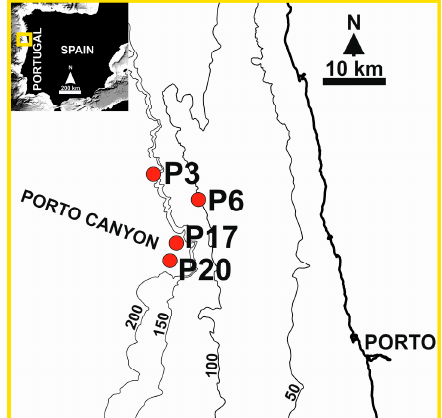
Figure 11. Location of the samples subjected to electron microprobe analysis (new data) in the Porto canyon area (red dots corresponding to samples P3, P16, P17, and P20).